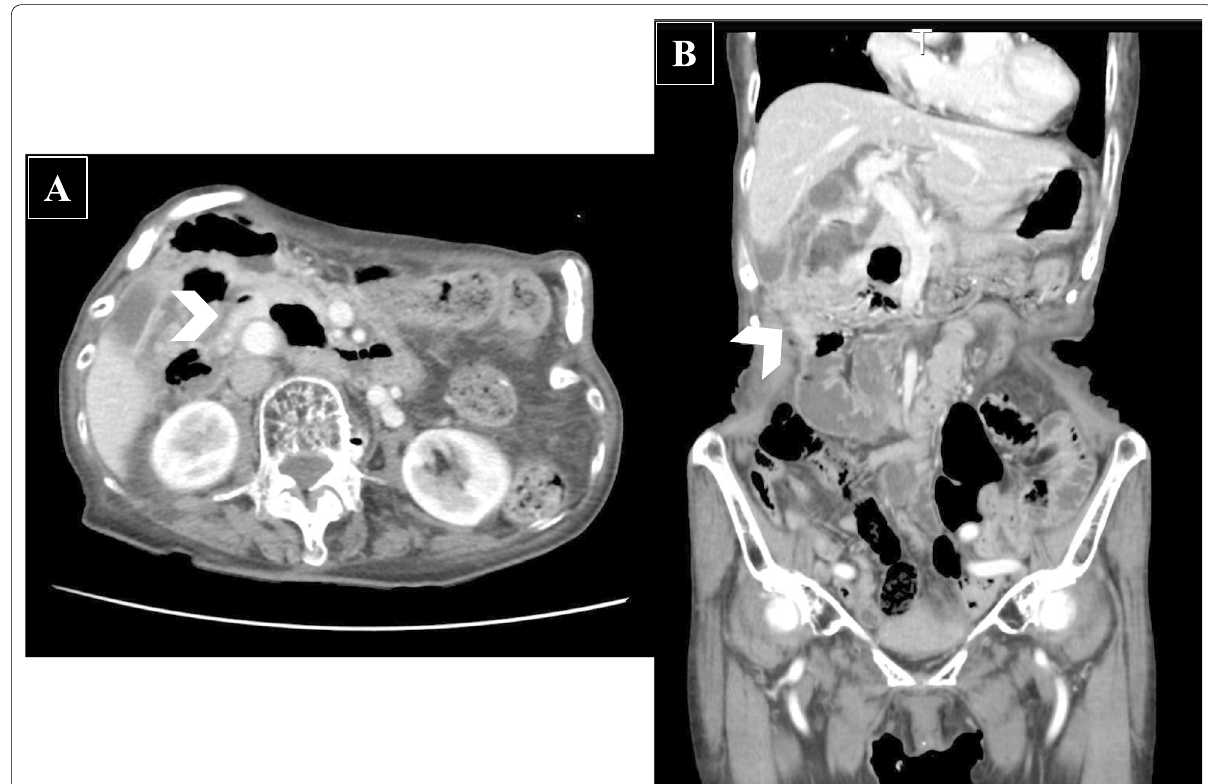
Fig. 1 Contrast material-enhanced computed tomography. A Axial contrast-enhanced CT shows enhancement of thickened duodenal wall ( arrowhead ). B Reformatted coronal contrast-enhanced CT image also detects the thickened duodenal wall with inflammation involving periduodenal fat ( arrowhead